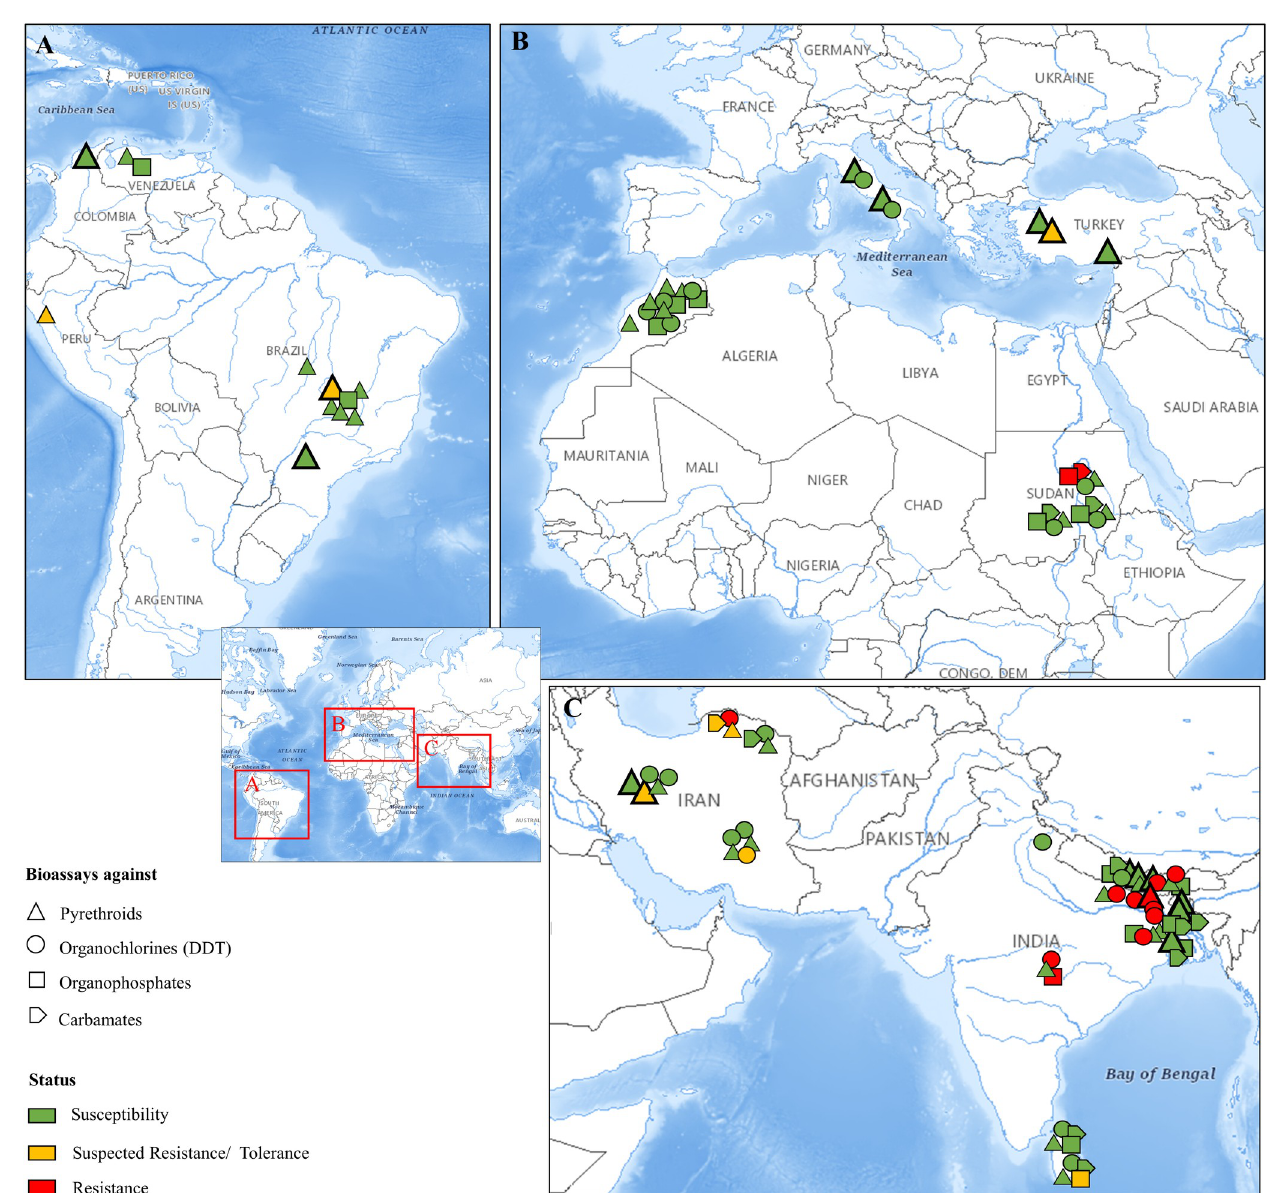
Fig 1. Global geographical distribution of IR bioassay reports in Lutzomyia and Phlebotomus sand fly vector species. The global map focuses in regions with data coverage since 2000: (A) Latin America, (B) Mediterranean basin and north-central Africa, and (C) the Middle East and southeastern Asia. The sand fly species analyzed per region are (A) L . longipalpis , L . evansi , and L . peruensis , (B) mainly, P . papatasi , P . sergenti , and P . tobbi , and (C) mainly, P . papatasi , P . sergenti , and P . argentipes . Data correspond to WHO tube or CDC bottle bioassays in adult field-caught sand fly populations, against compounds of the 4 main insecticide classes. For WHO and CDC bioassay experiments using insecticide discriminating doses, the resistance status is determined by the mortality percentage (%) recorded 24 hours post-exposure (1 hour of exposure), as follows: � 98% shows susceptibility (green), 90%–97% indicates the possibility of resistance (yellow), and < 90% denotes resistance (red). Regarding the cases where (i) KD rates (%) at 1 hour of exposure are given; (ii) other than discriminating doses were tested; or (iii) dose–or time–response KD/mortality curves were provided, the susceptibility/resistance status is presented as defined by the respective authors. The symbol size varies depending on the number of insecticides of the same class tested against a specific population. In cases of differences in the population’s response against these insecticides, the less sensitive condition is presented. A detailed dataset for each bioassay experiment is provided in S1 Table. Maps were obtained from USGS (https://apps.nationalmap.gov/viewer/). DDT, dichloro-diphenyltrichloroethane; IR, insecticide resistance; USGS, US Geological